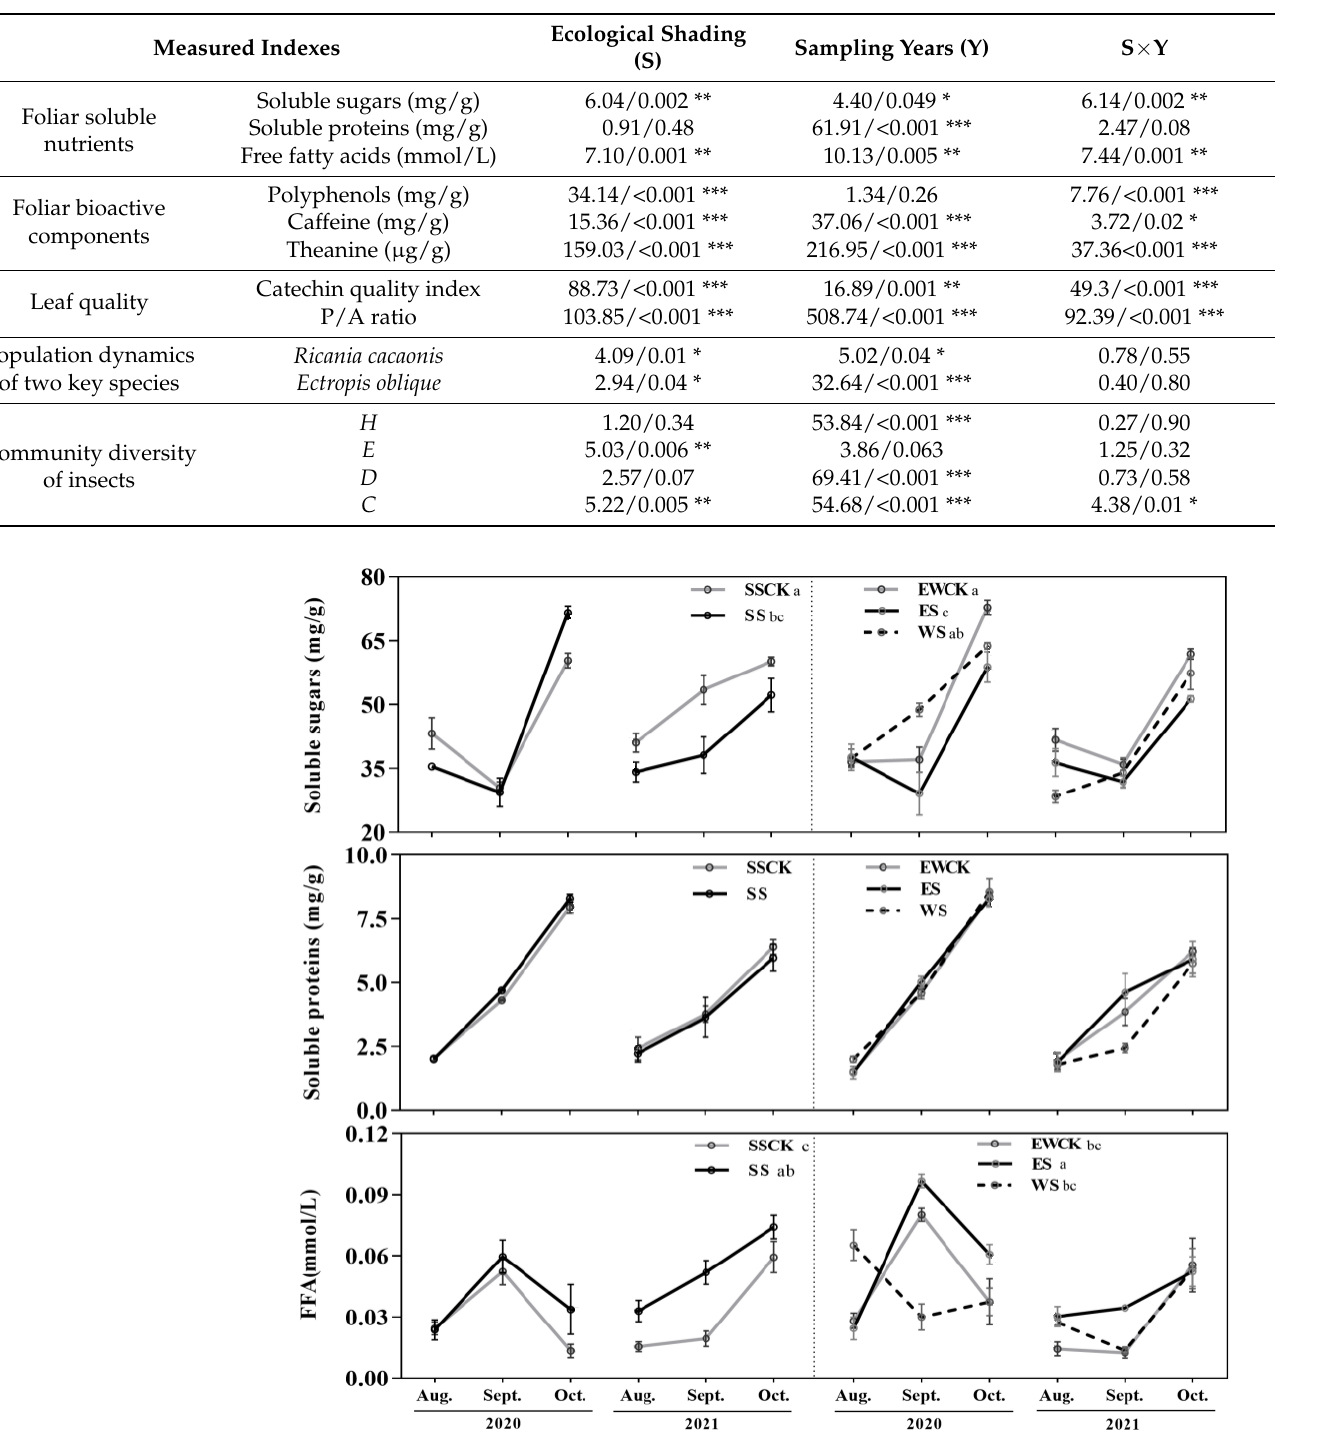
Table 1. Two-way repeated-measures ANOVAs of ecological shading by roadside trees (S), sampling year (Y), and their interaction on the foliar contents of soluble nutrients, bioactive components, and leaf quality indices of tea plants, as well as the population occurrence of two key pests, R. cacaonis and E. oblique , and the community indices of collected insects in the tea plantation (values were F / p ) (sampling time was repeated measures; * p < 0.05; ** p < 0.01; *** p < 0.001).